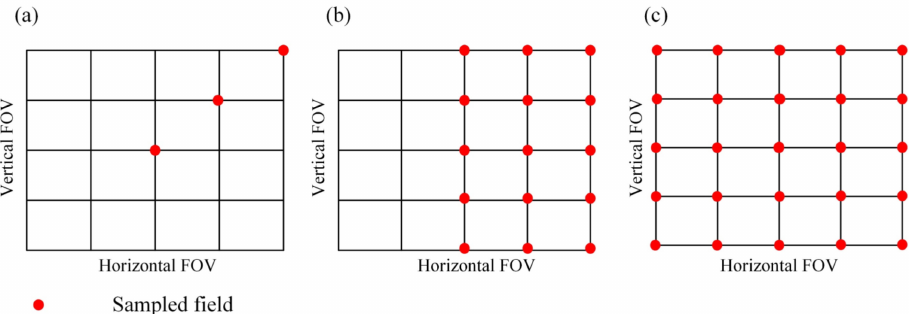
Figure 2. Sampled fields of the ( a ) rotational symmetry system, ( b ) planar symmetry system, and ( c ) nonsymmetric system.